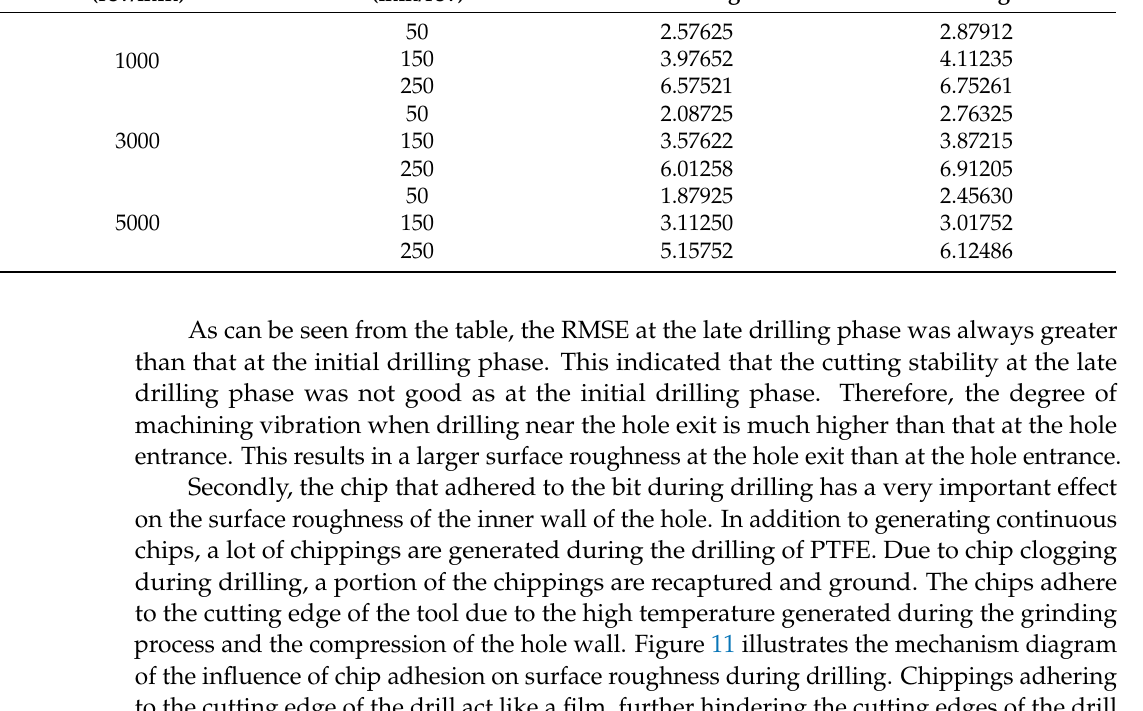
Figure 10. Surface roughness of hole inner wall under different cutting parameters: ( a ) Surface roughness of hole entrance; ( b ) Surface roughness of hole exit.